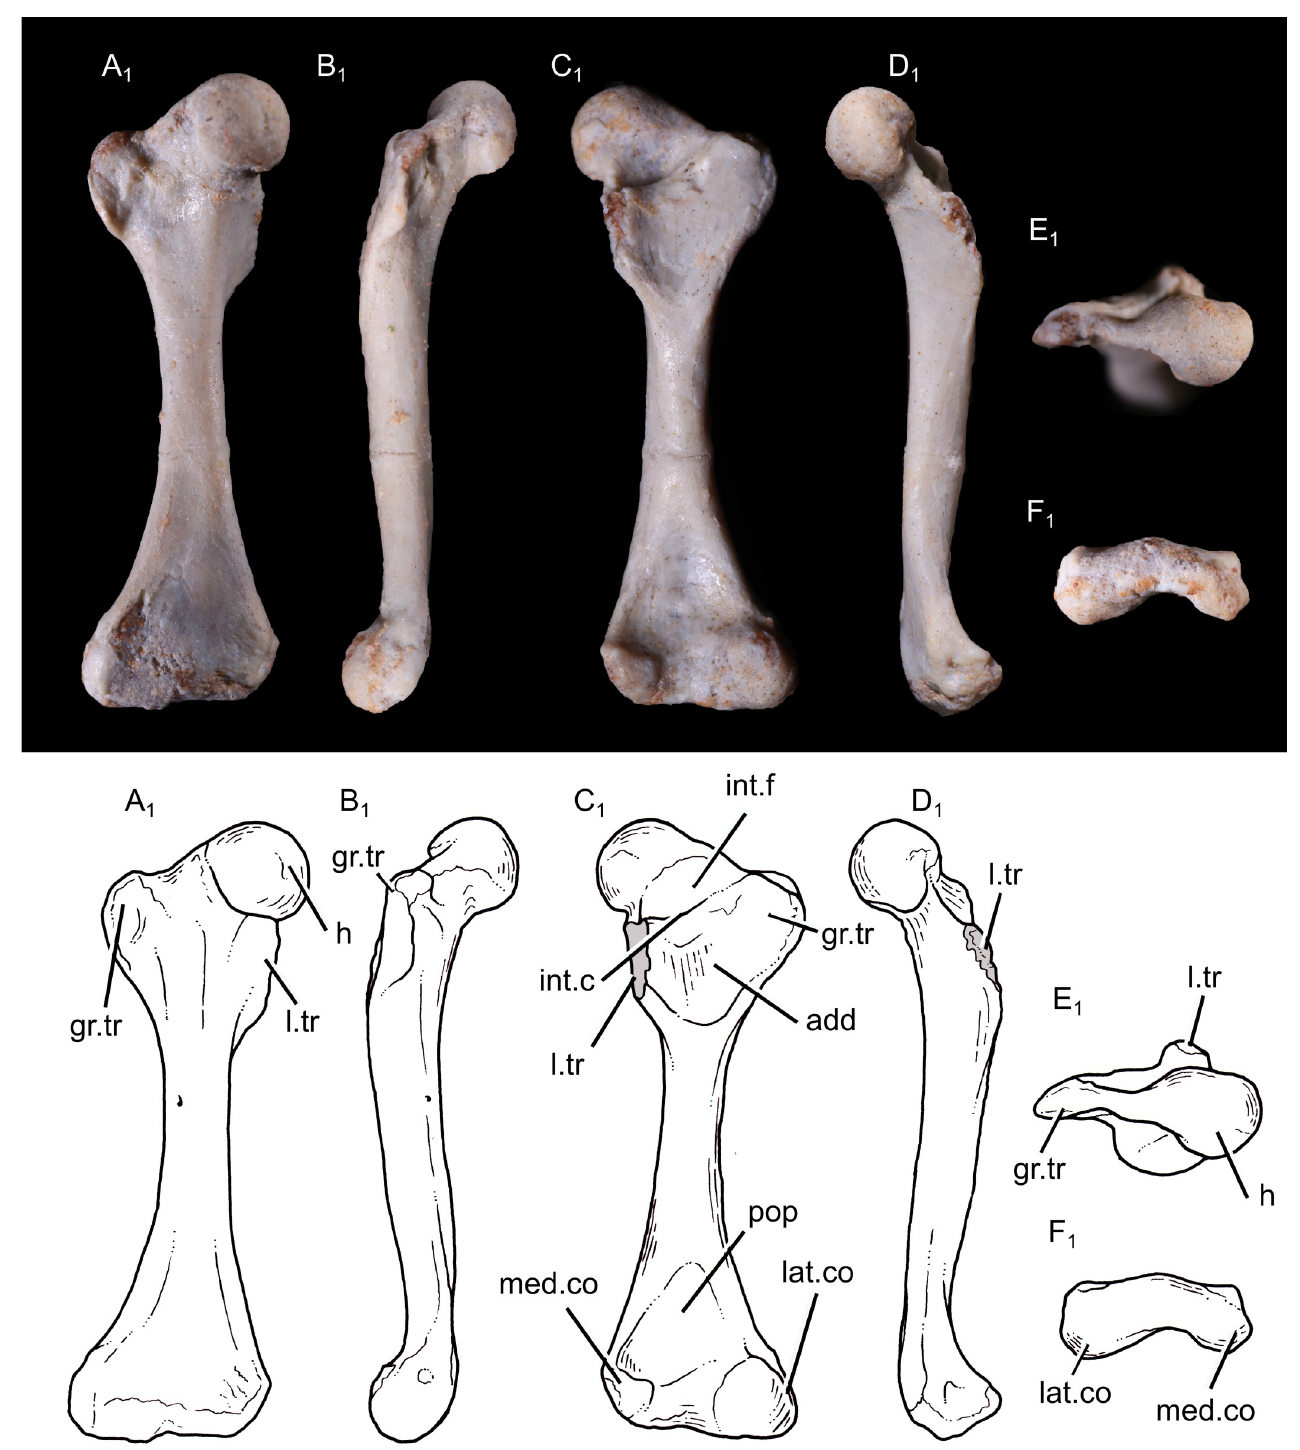
Fig 6. Photography (1) and drawing (2) of the right femur of Brasilodon quadrangularis (UFRGS-PV-1043-T). A , right femur in anterior view; B , right femur in lateral view; C , right femur in posterior view; D , right femur in medial view; E , right femur in proximal view; F , right femur in distal view. Abbreviations: add , fossa for hip adductor muscles; gr.tr , greater trochanter; h , femoral head; int.c , intertrochanteric crest; int.f , intertrochanteric fossa; lat.co , lateral condyle; l.tr , lesser trochanter; med.co , surface for the medial condyle; pop , popliteal fossa. Scale bar = 3 mm.